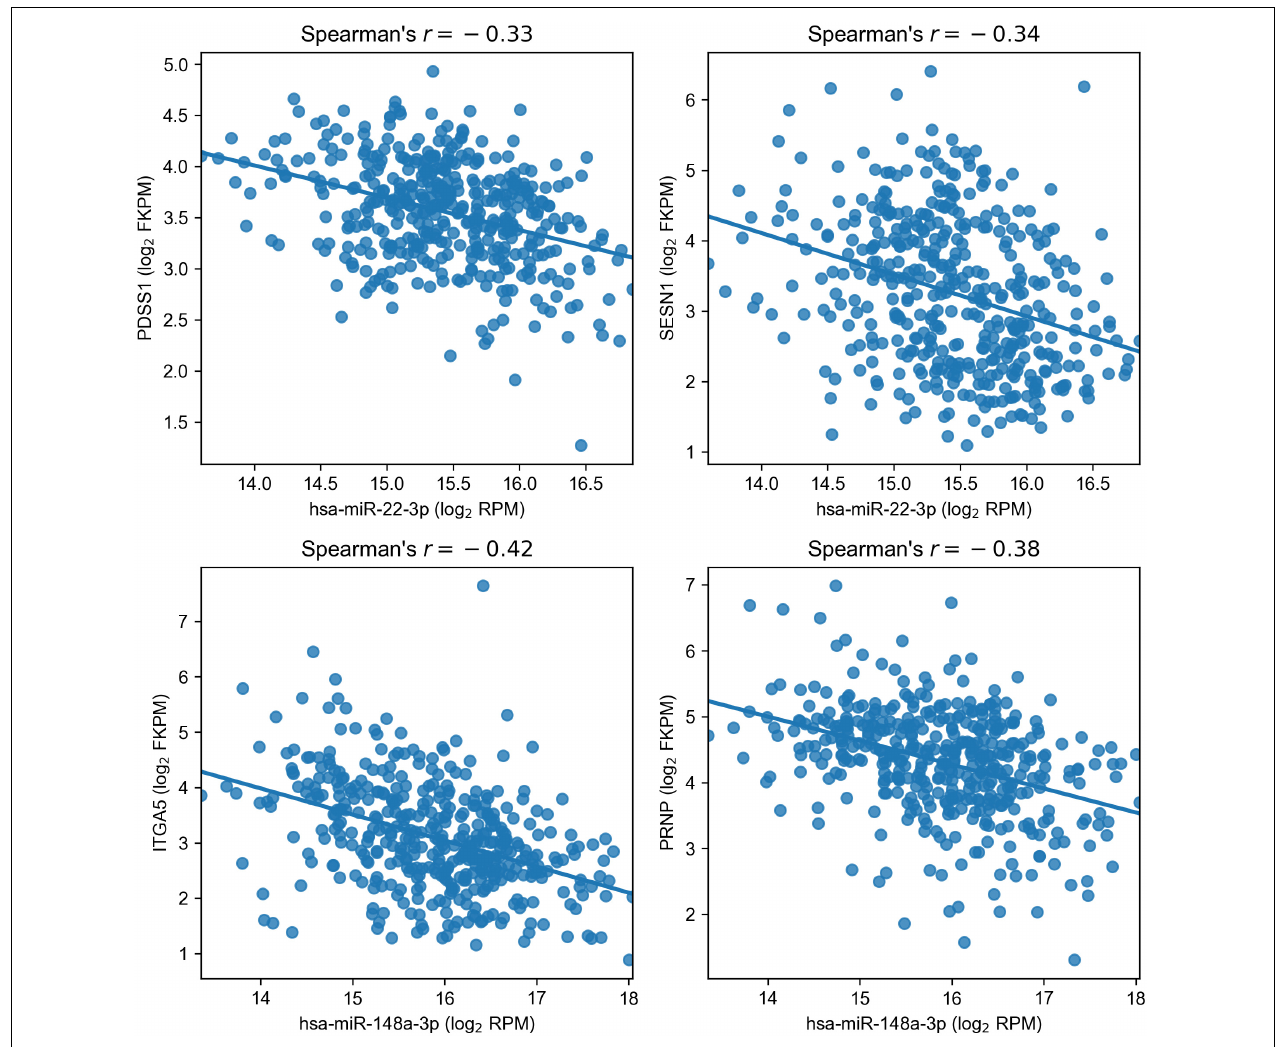
FIGURE 4 | Negative correlation of miR-22 and miR-148a with their target genes in The Cancer Genome Atlas Colon Adenocarcinoma